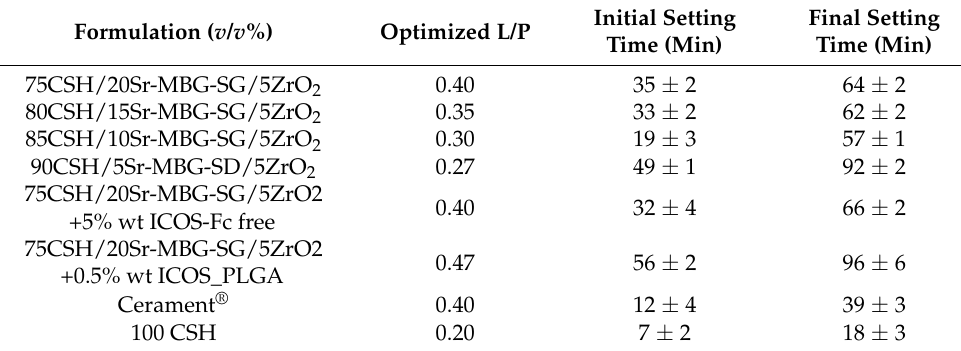
Table 3. Setting times of the selected cement formulations and controls evaluated in accordance with the standard